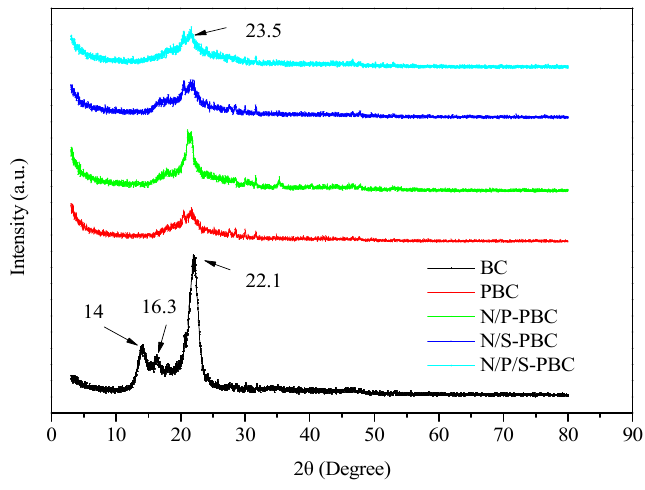
Figure 5. XRD patterns of BC, PBC, N/P-PBC, N/S-PBC and N/P/S-PBC.